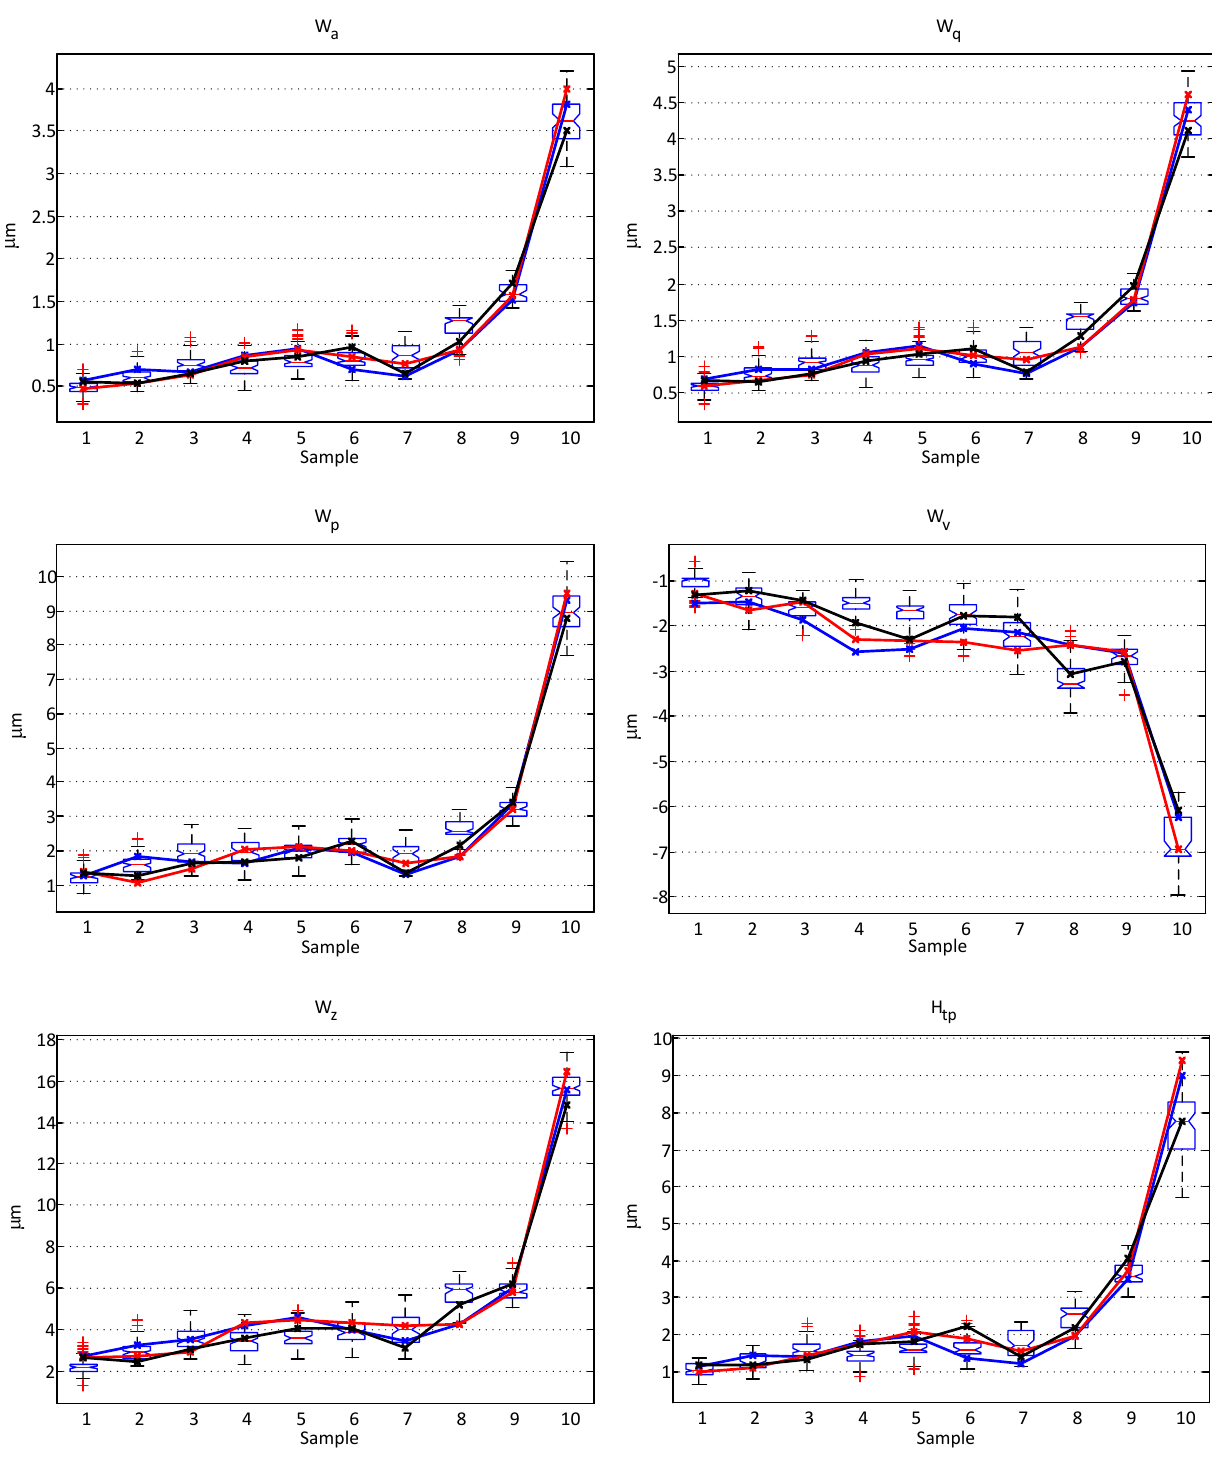
Figure 7. Comparison of results between a contact stylus profilometer and the proposed optical sensor for each of of the waviness parameters W a cutoff wavelength of 0.25 mm. The boxplots represent the dispersion of the parameters calculated using the optical sensor data from more than 70 profiles of each sample. The continuous lines represent the parameters calculated over three different profiles obtained from the contact stylus